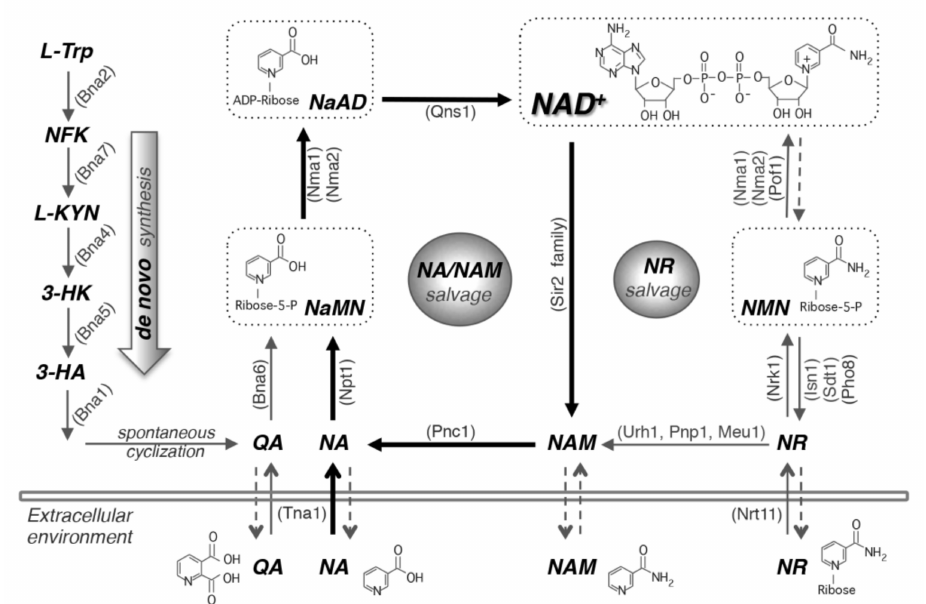
Figure 1. NAD + biosynthesis pathways. In yeast cells, NAD + can be made by salvaging precursors such as NA, NAM and NR or by de novo synthesis from tryptophan. Yeast cells also release and re-uptake these precursors. The de novo NAD + synthesis (left panel) is mediated by Bna proteins (Bna2,7,4,5,1) leading to the production of NaMN. This pathway is inactive when NAD + is abundant. The NA / NAM salvage pathway (center panel) also produces NaMN, which is then converted to NaAD and NAD + by Nma1 / 2 and Qns1, respectively. NR salvage (right panel) connects to the NA / NAM salvage pathway by Urh1, Pnp1 and Meu1. NR turns into NMN by Nrk1, which is then converted to NAD + by Nma1, Nma2 and Pof1. This model centers on NA / NAM salvage (highlighted with bold black arrows) because most yeast growth media contain abundant NA. Cells can also salvage NaR by converting it to NA or NaMN. For simplicity, NaR salvaging is not shown in this figure. Arrows with dashed lines indicate the mechanisms of these pathways remain unclear. NA, nicotinic acid. NAM, nicotinamide. NR, nicotinamide riboside. NaR, nicotinic acid riboside. QA, quinolinic acid. L-TRP, L-tryptophan. NFK, N-formylkynurenine. L-KYN, L-kynurenine. 3-HK, 3-hydroxykynurenine. 3-HA, 3-hydroxyanthranilic acid. NaMN, nicotinic acid mononucleotide. NaAD, deamido-NAD + . NMN, nicotinamide mononucleotide. Abbreviations of protein names are shown in parentheses. Bna2, tryptophan 2,3-dioxygenase. Bna7, kynurenine formamidase. Bna4, kynurenine 3-monooxygenase. Bna5, kynureninase. Bna1, 3-hydroxyanthranilate 3,4-dioxygenase. Bna6, quinolinic acid phosphoribosyltransferase. Nma1 / 2, NaMN / NMN adenylyltransferase. Qns1, glutamine-dependent NAD + synthetase. Npt1, nicotinic acid phosphoribosyltransferase. Pnc1, nicotinamide deamidase. Sir2 family, NAD + -dependent protein deacetylases. Urh1, Pnp1 and Meu1, nucleosidases. Nrk1, NR kinase. Isn1 and Sdt1, nucleotidases. Pho8 and Pho5, phosphatases. Pof1, NMN adenylyltransferase. Tna1, NA and QA transporter. Nrt1, NR